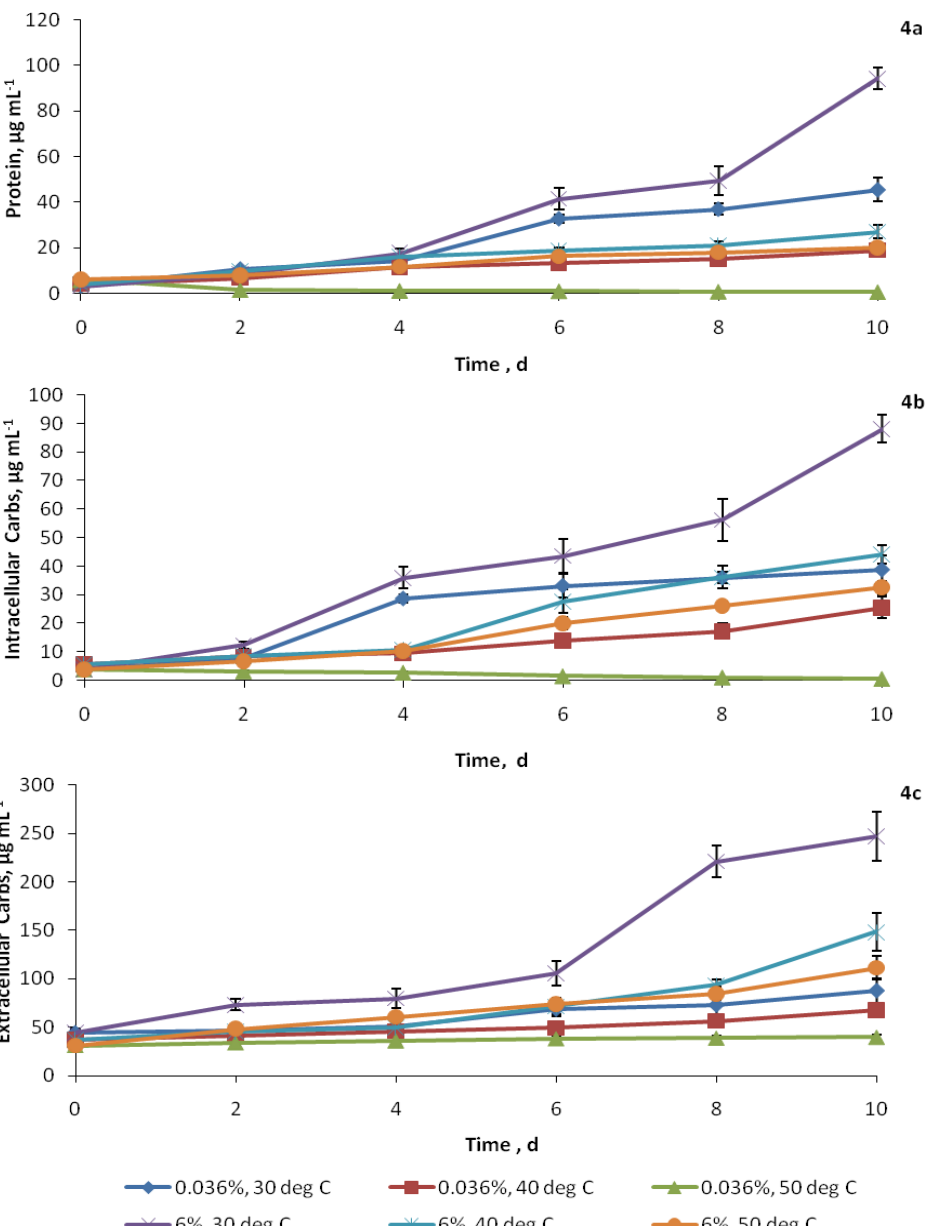
Figure 4. Effect of elevated CO and temperature on (a) protein, (b) intracellular and (c) 2 extracellular carbohydrates (µg mL -1 ) of C.